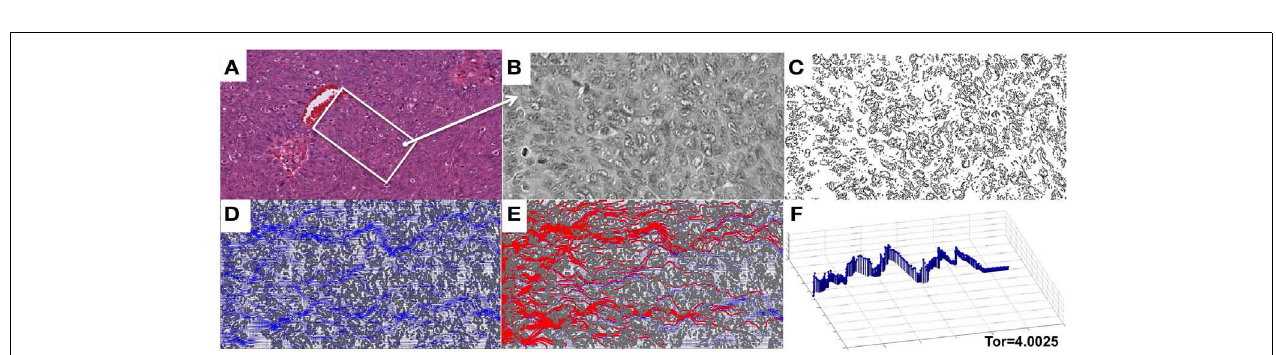
from (B) used for computational simulations. (D) The simulated interstitial fluid flow (blue). (E) The resulting traces of the simulated particles representing the drug or biomarker molecules. (F) The particle trace with maximal tortuosity of